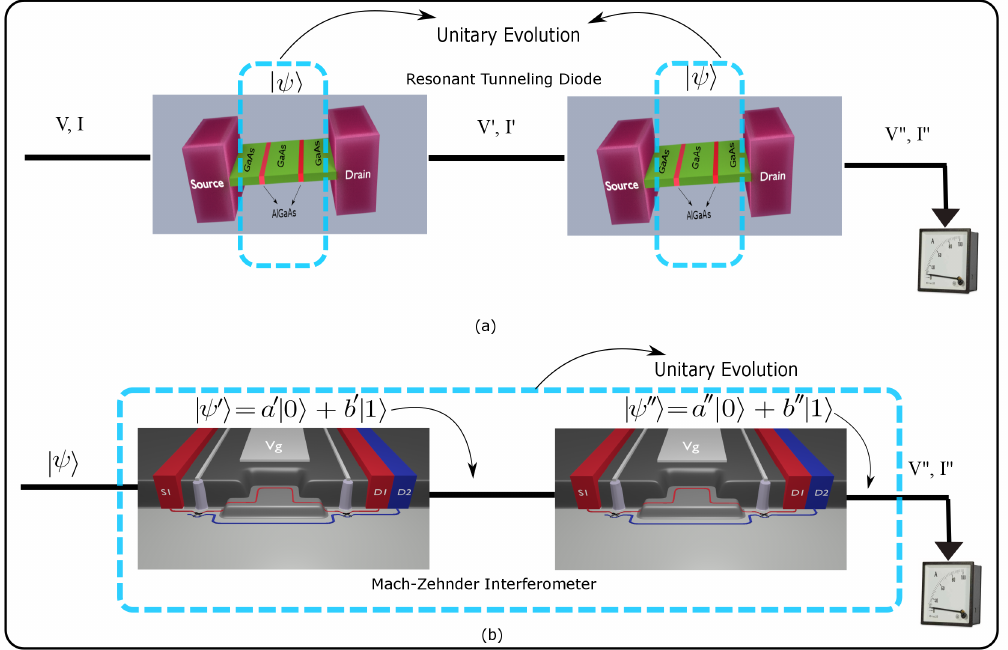
Figure 1. ( a ) Schematic of classical computing exemplified with RTD where only the active device is governed by unitary quantum evolutions (enclosed in the cyan color dashed line), while the contacts and the cable leads to quantum decoherence which provides a fixed value of the current obtained in the measuring apparatus (shown at the right end). ( b ) Schematic of quantum computing exemplified with an MZI where the quantum wholeness require that a coherent unitary evolution appears in all the gates (enclosed in the cyan color dashed line). Only at the end, when the wave function is measured, decoherence can be